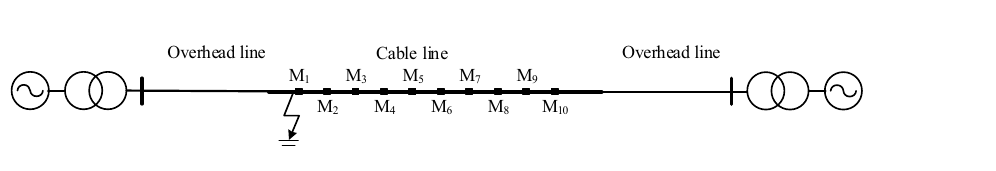
Figure 7. Simulation model of traveling wave energy changes of cable lines (scenario 2).